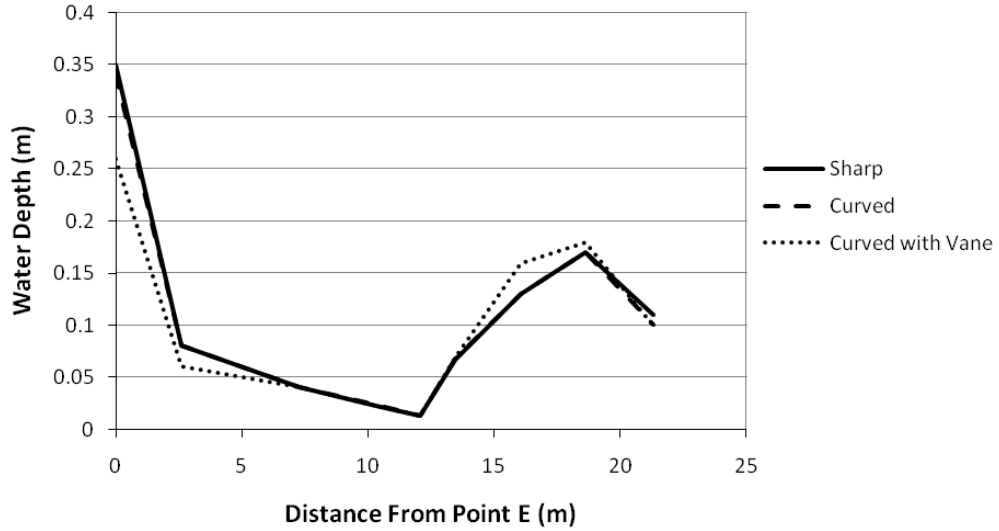
Figure 17. Water depth variation along C-Ss for HDS scenario (at monitoring